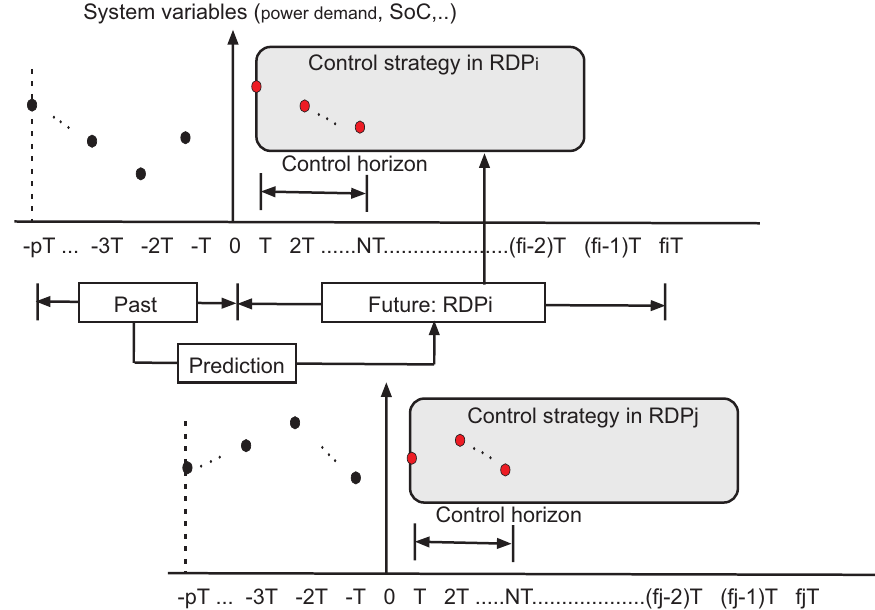
Figure 3. Driving pattern recognition and control (according to